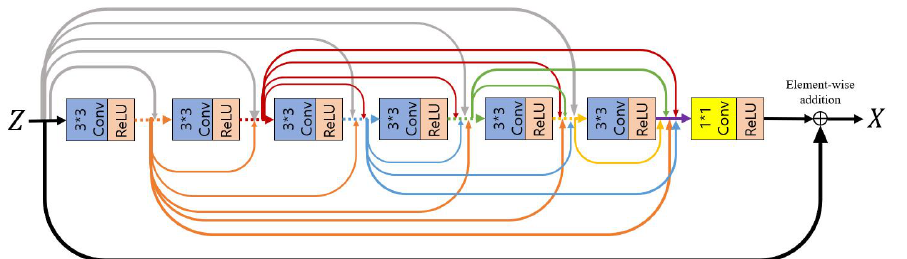
Figure 5. A residual dense convolutional block is composed of dense concatenations based on skip-connections between a series of convolutional blocks consisting of convolutions and ReLU activation functions.